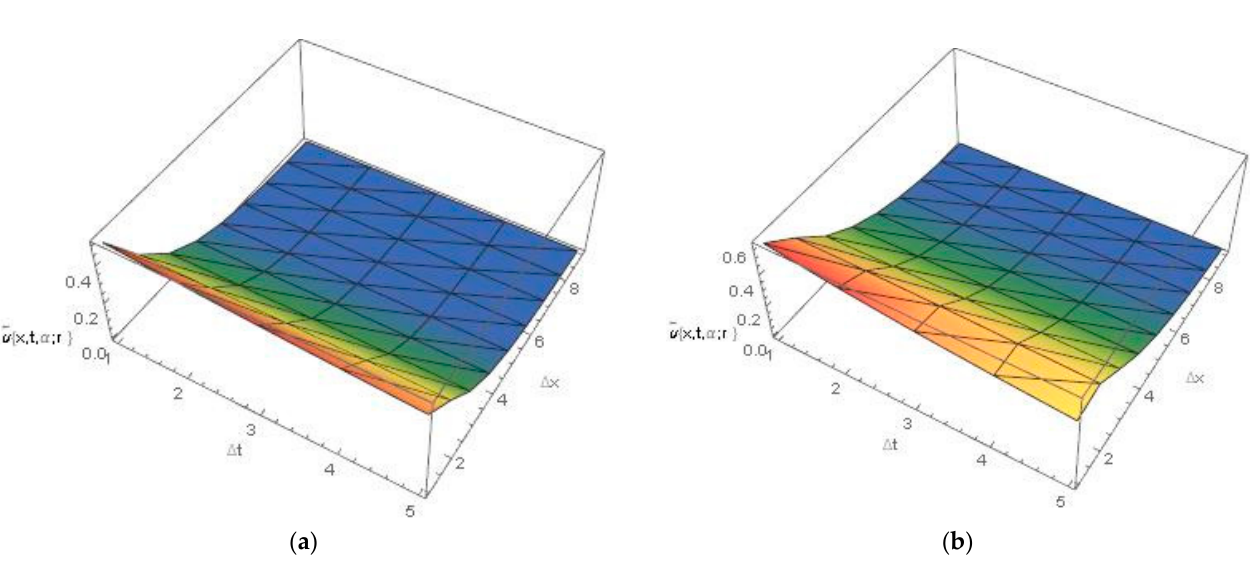
Figure 5. ( a , b ) fuzzy numerical solution of Equation (30), at different time and space steps at 𝛼 = 0.9 for all 𝑟 ∈ [0,1] .